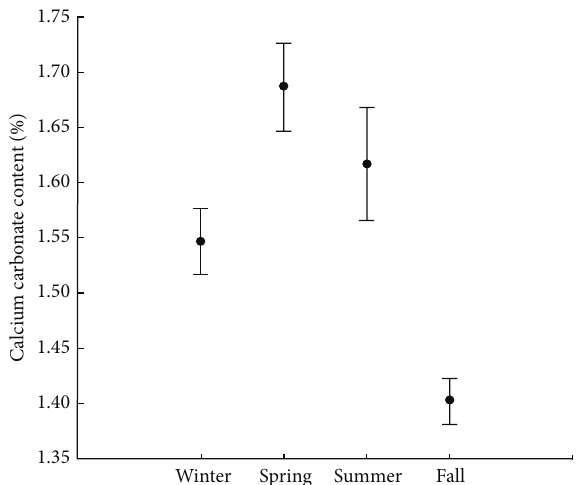
Figure 3: Mean values of calcium carbonate of Saco da Fazenda, during the seasons of sampled period (mean ± standard error).